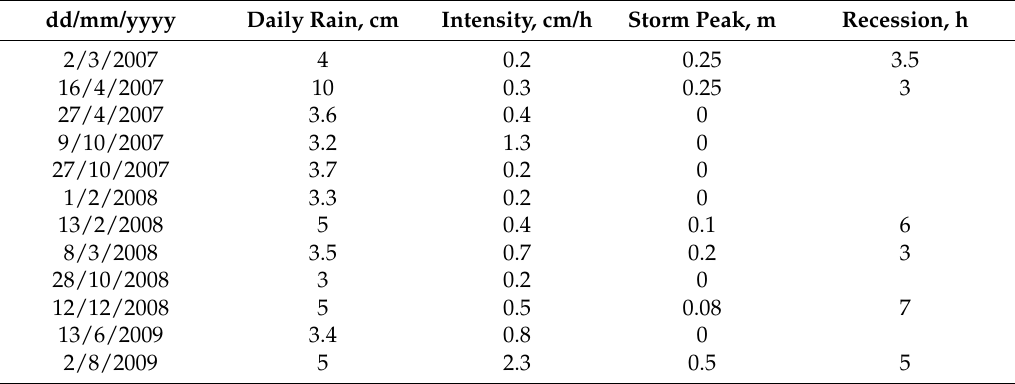
Table 1. Summary of storm responses in parking lot infiltration chamber for events greater than 3 cm for 2.7 years of